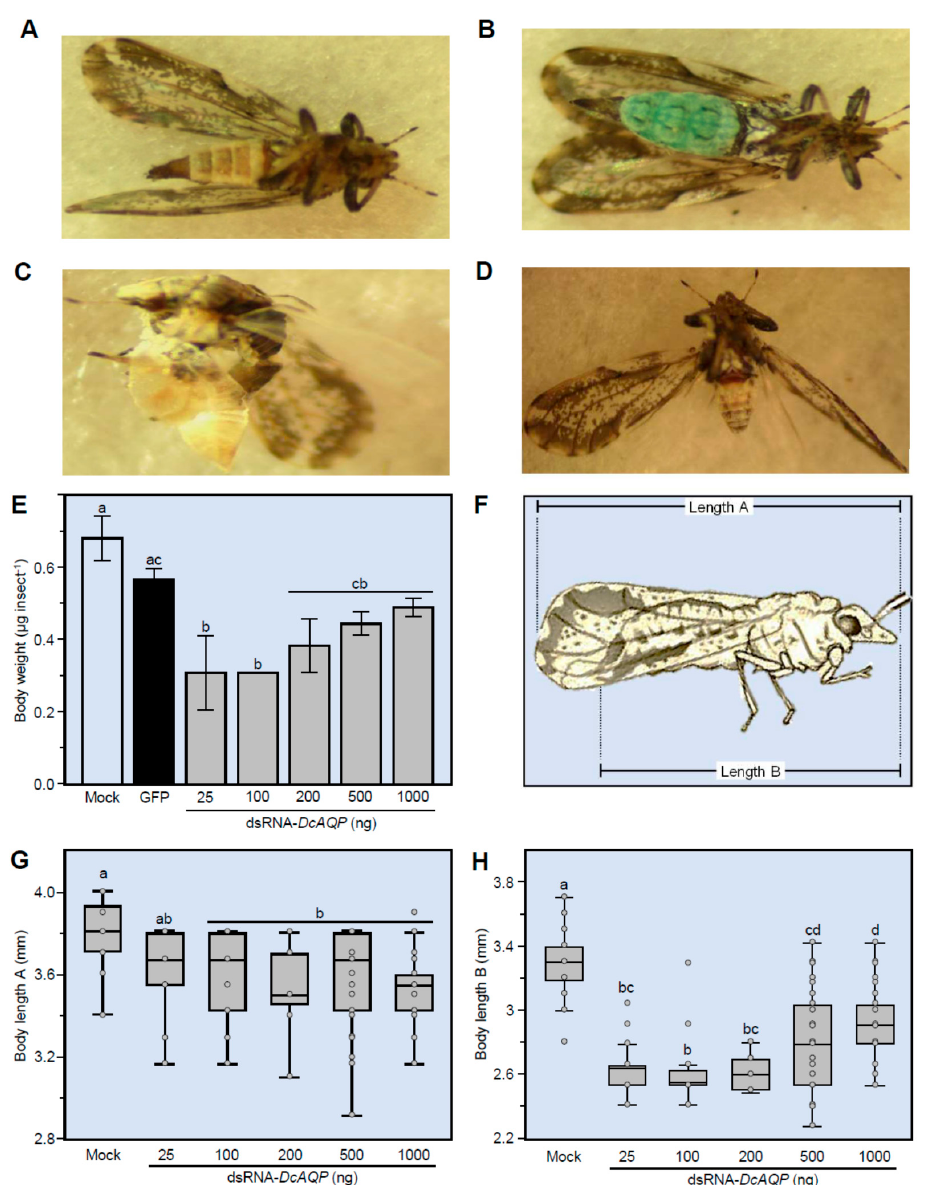
Figure 6. Effect of DcAQP silencing on the body weight and length of emerged adults of D. citri from treated nymphs. ( A – D ) Malformations of emerged adults of D. citri from treated nymphs after the treatment with dsRNA- DcAQP . ( E ) Body weight of D. citri adults emerged from nymphs after the treatment with different concentrations of dsRNA- DcAQP (25, 100, 200, 500 and 1000 ng·µL − 1 ) in comparison with RNase-free water and dsRNA- GFP as controls. Bars and error bars represent means and SDs, respectively. Different letters indicate statistically significant differences among treatments, while the same letter signifies no significant differences among treatments using Tukey– Kramer honestly significant different test (Tukey HSD; p < 0.05). ( F ) Graphic illustration represents how the body length was measured. “Length A” covers the distance from the beginning of the head to the end of the wings, whereas “length B” covers the distance from the beginning of the head to the end of the body. ( G ) and ( H ) Body length (“Length A” and “Length B”, respectively) of D. citri adults emerged from nymphs after the treatment different concentrations of dsRNA- DcAQP (25, 100, 200, 500 and 1000 ng·µL − 1 ) in comparison with RNase-free water as control. Horizontal thick lines indicate the medians; black or white dots indicate the means; boxes show the interquartile ranges including 25–75% of the values; whiskers reflect the highest and the lowest value of data. Different letters indicate statistically significant differences among treatments using Tukey HSD ( p <